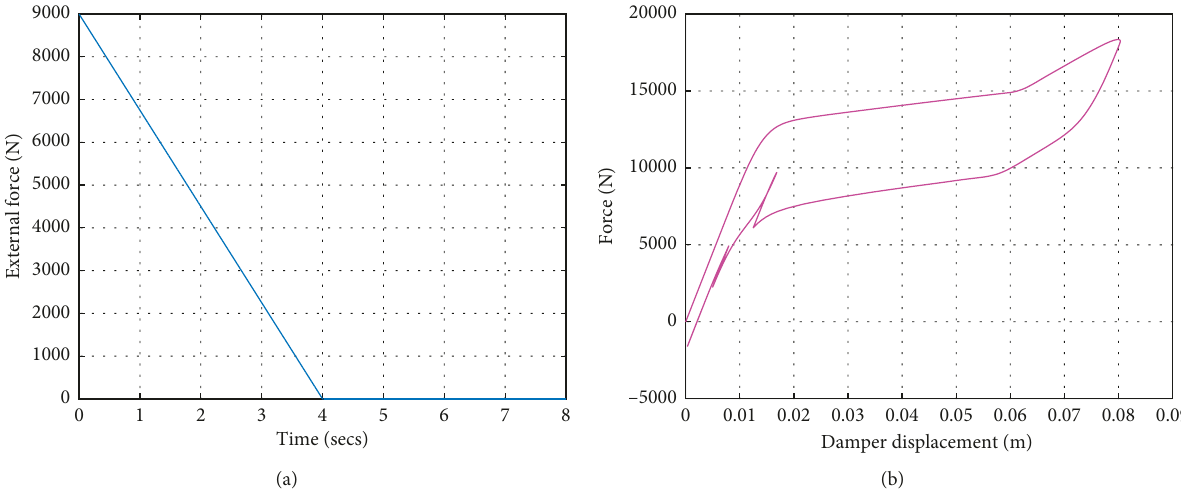
Figure 13: Decreasing load followed by free vibration. External load (a) and damper response (b).